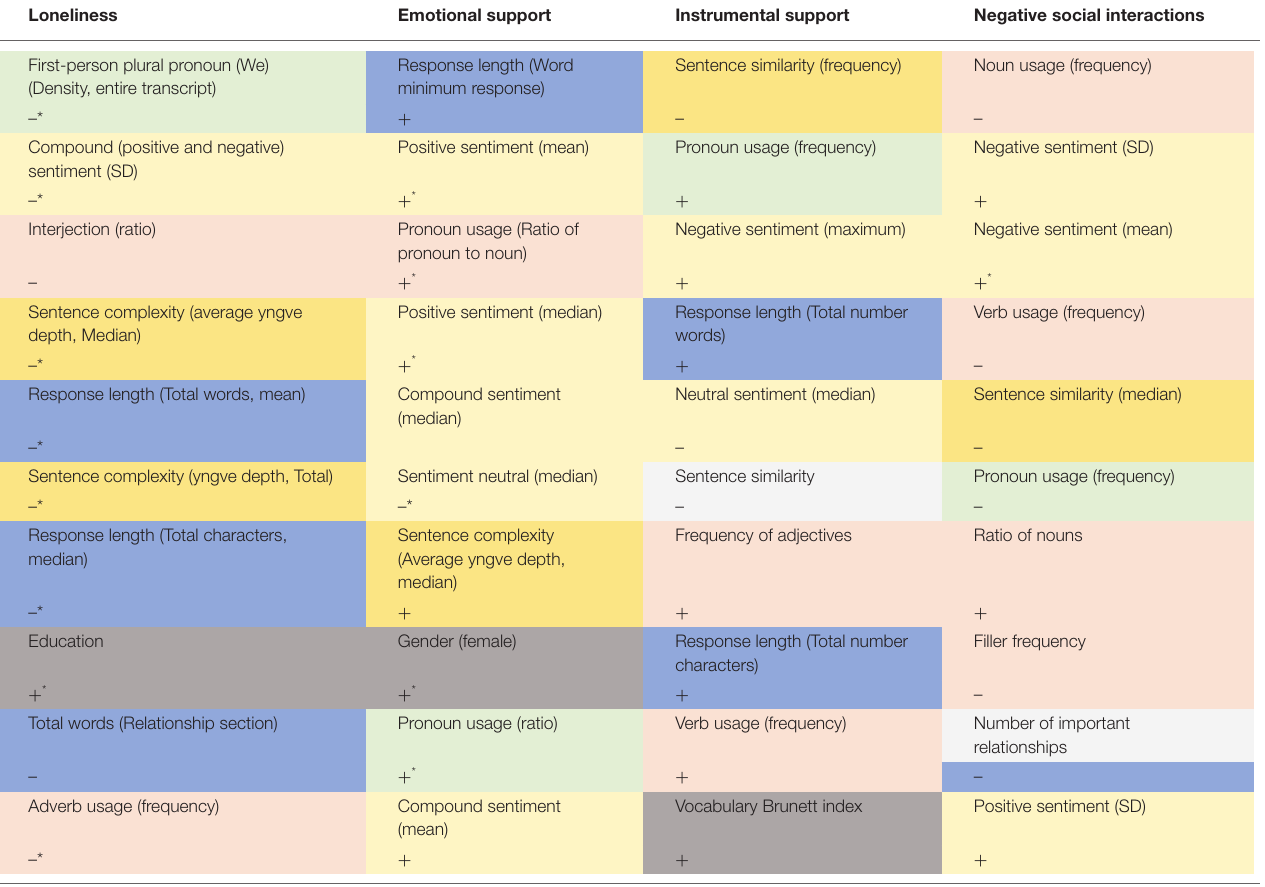
A:Binary-classification performance for social and emotional support at median (Leave one out) * .